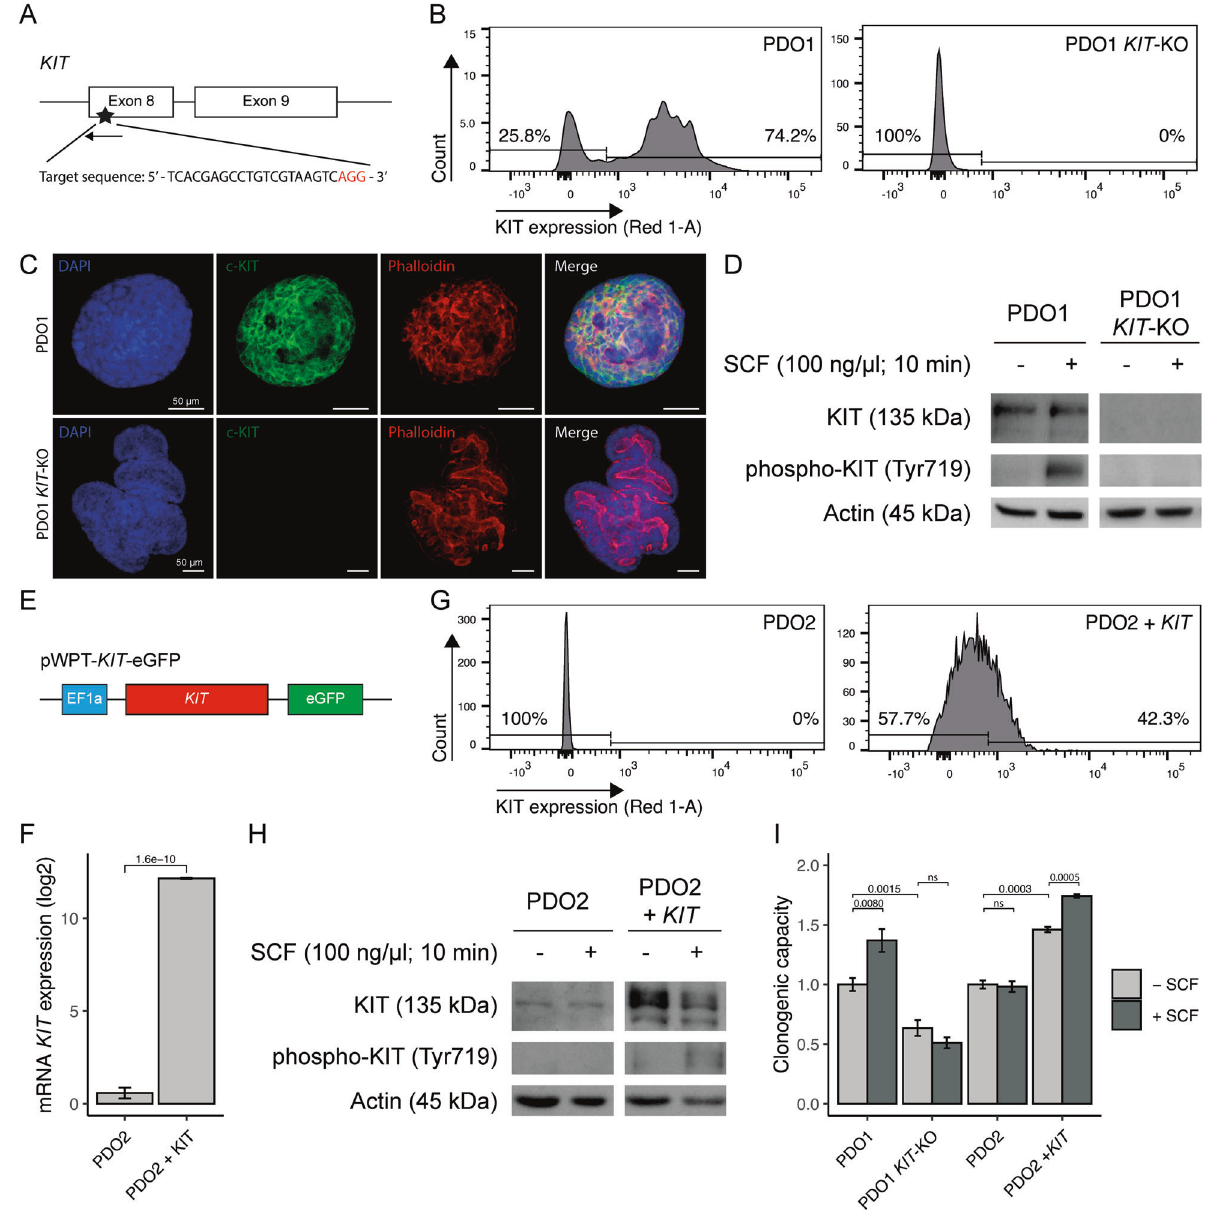
Fig. 2 Genomic engineering of KIT in patient-derived tumor organoids increases regenerative capacity. A Schematic overview of CRISPR- Cas9 mediated KIT gene knockout in PDO1. Designed single-guide RNA targets KIT exon 8. B Flow-cytometry analyses showing deletion of cell-surface KIT expression in PDO1 KIT-KO . C Immuno fl uorescence imaging demonstrating DAPI, c-KIT, and Phalloidin staining in PDO1 CONTROL and PDO1 KIT-KO , scale bar is 50 µm. D Western blot analysis of KIT and phosphorylated KIT upon stimulation with stem-cell factor (SCF, 100 ng/ µl) for 10 min in PDO1 CONTROL and PDO1 KIT-KO . E Schematic overview of lentiviral vector to overexpress KIT, which is driven by the human EF1a promotor in PDO2. F mRNA levels of KIT expression in PDO2 CONTROL and generated PDO2 KIT variant. G Flow-cytometry analyses